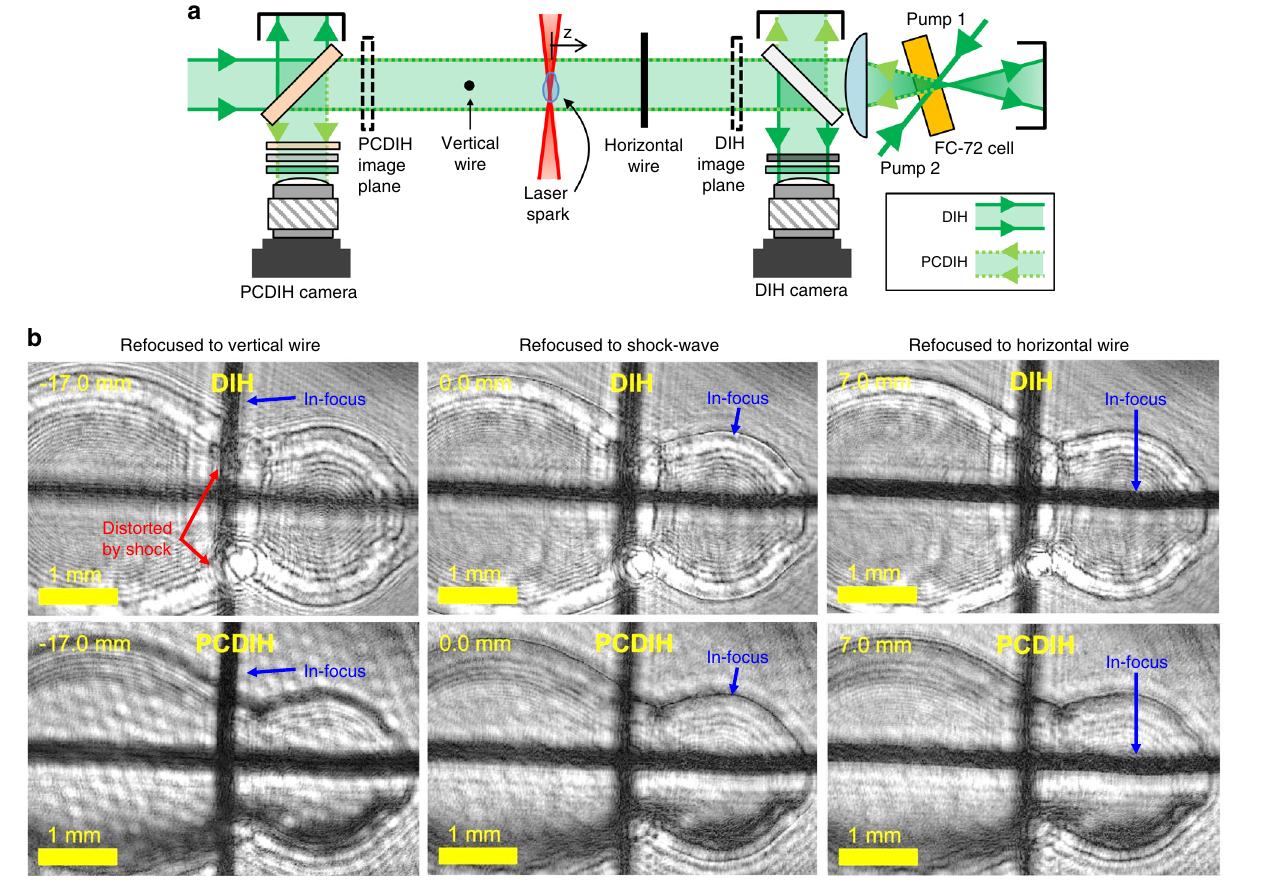
Fig. 4 Numerically refocused holograms of a laser-spark plasma-generated shock-wave. a Simpli fi ed setup and b refocused holograms are illustrated. A single hologram from each camera is refocused to the focal plane of the vertical wire ( z = − 17 mm), laser spark ( z = 0 mm), and horizontal wire ( z = 7 mm). Note that the overall image brightness was increased to improve visibility and that the pixels are not saturated. Supplementary Movie 1 associated with this fi gure illustrates numerical